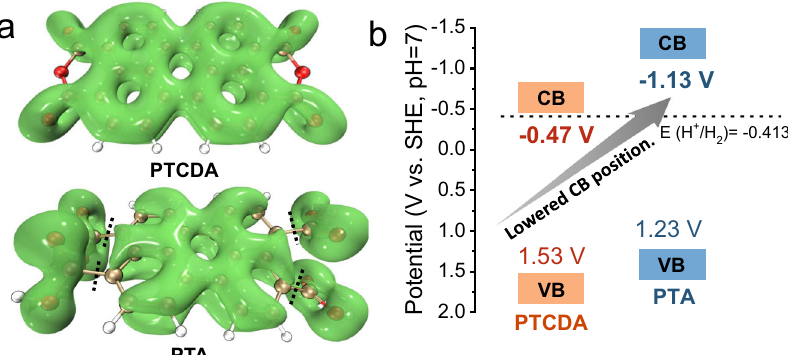
Fig. 3 The reduction potential of the PTA photocatalyst. a The localized orbital locator- π (LOL- π ) isosurface. b The band structures of PTCDA and PTA measured